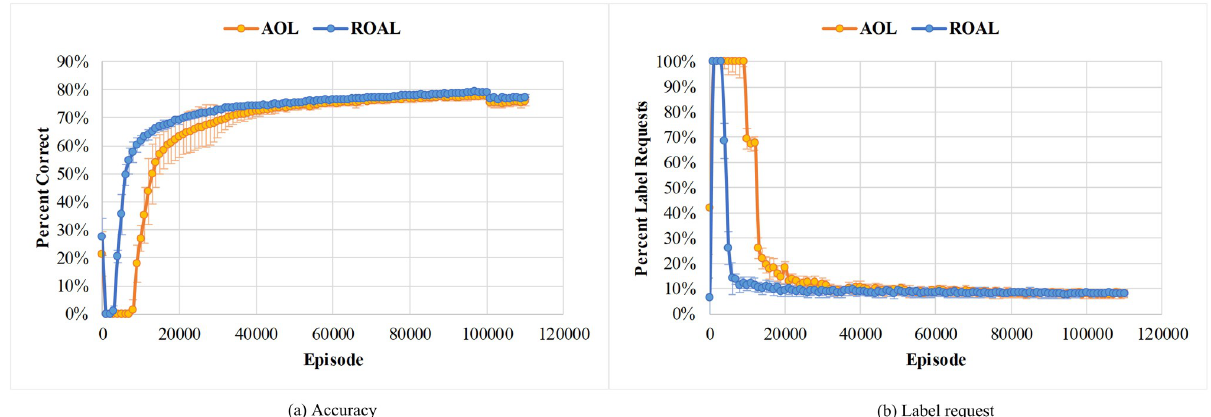
Fig 5. Comparison of overall (a) Accuracy and (b) Label request results between ROAL and AOL. Compared to AOL, ROAL is able to achieve higher accuracy and lower request rate in fewer iterations. After 100,000 episodes, the data switches to test set without further learning.